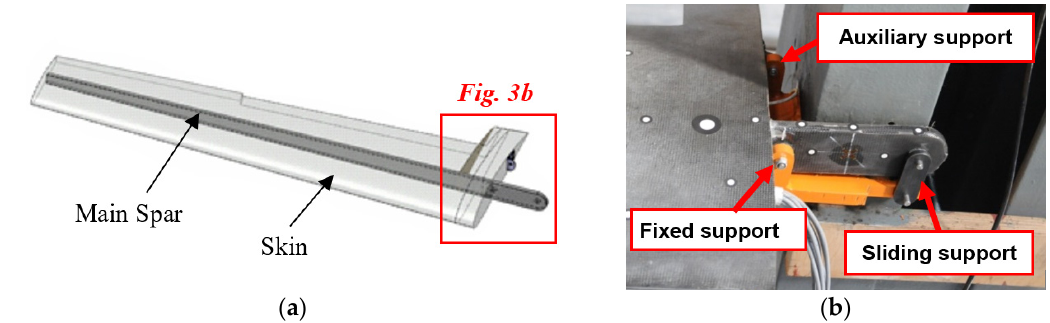
Figure 3. CAD geometry of tested wing ( a ) and details of carry through structures and attachment part of the test stand ( b ).